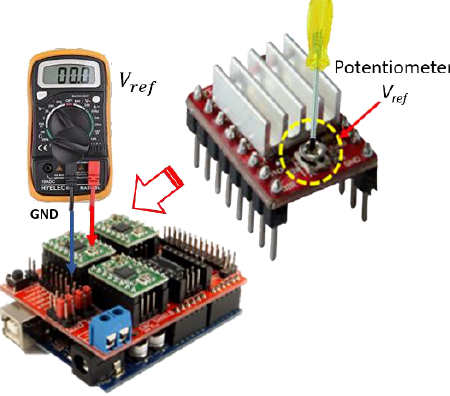
10 of 23 Figure 10. V ref setting values with R s = 0.2 ohms with respect to motor current. Table 5. V ref of the A4988 drivers. Driver